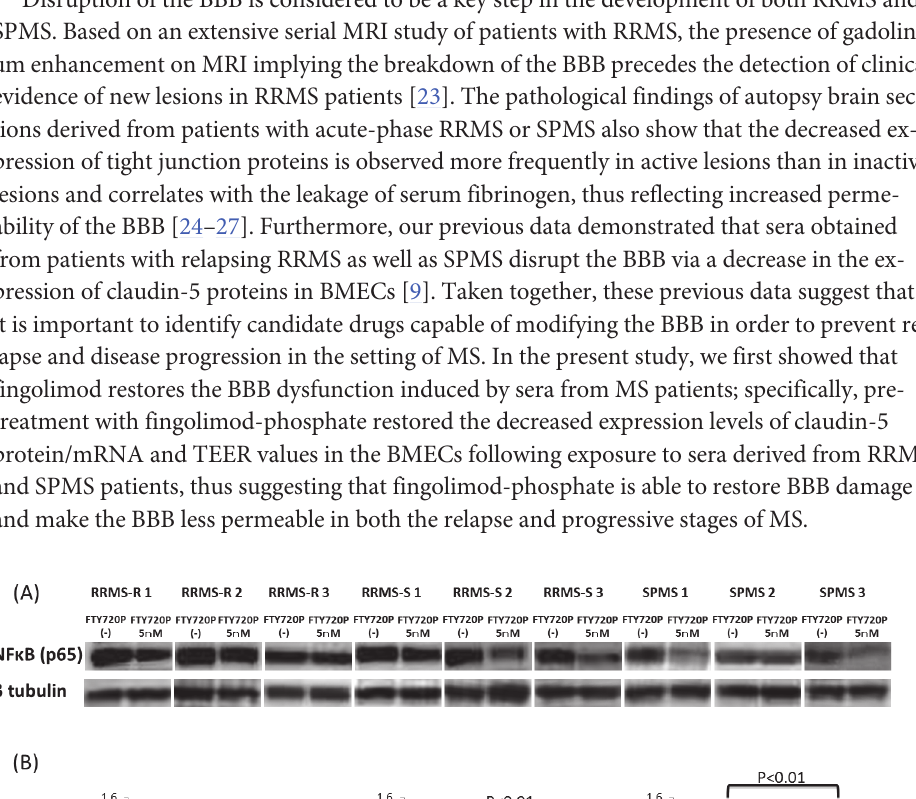
Fig 2. The effects of pretreatment with fingolimod-phosphate on BMECs in the presence of MS sera. (A) The effects of pretreatment with fingolimod-phosphate on the expression of tight junction proteins and adhesion molecules in the human brain microvascular endothelial cells (BMECs) in the presence of MS sera were determined using a Western blot analysis. (B)(C)(D)(E)(F) Each bar graph reflects the combined densitometry data for the independent experiments (mean ± SEM, RRMS-R n = 3, RRMS-S n = 3, SPMS n = 3). Pretreatment with fingolimod-phosphate resulted in an increase in the claudin-5 protein levels (B) and TEER values (G) and a decrease in the VCAM-1 protein levels (F) in the BMECs, which were upregulated after exposure to the sera from all MS patients, including the RRMS-R, RRMS-S and SPMS patients, compared to that observed in the cells not pretreated with fingolimod-phosphate.